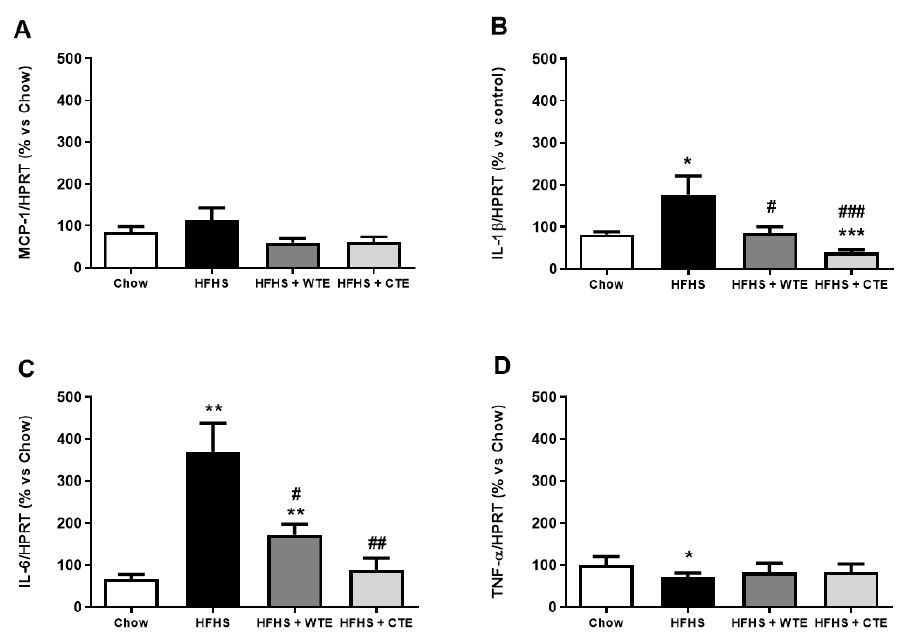
Figure 7. Gene expression of monocyte chemoattractant protein (MCP-1) ( A ), interleukin-1 beta (IL- 1 β ) ( B ), interleukin-6 (IL-6) ( C ), and tumor necrosis factor-alpha (TNF- α ) ( D ) of mice fed a standard diet (Chow), a high-fat diet/sucrose diet (HFHS), a high-fat diet/sucrose diet supplemented with White Tea Extract (HFHS + WTE), or a high-fat diet/sucrose diet supplemented with Tea Complex Extract (HFHS + TCE). * p < 0.05; ** p < 0.01; *** p < 0.001 vs. chow. # p < 0.05; ## p < 0.01 vs. HFHS. The values are represented as the mean ± S.E.M (n = 7–10 samples/experimental group), and are expressed as a percentage vs. chow.